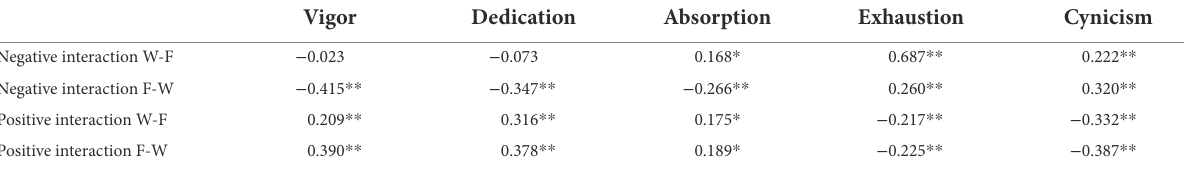
TABLE 4 Correlations between SWING subscales and engagement and burnout variables.